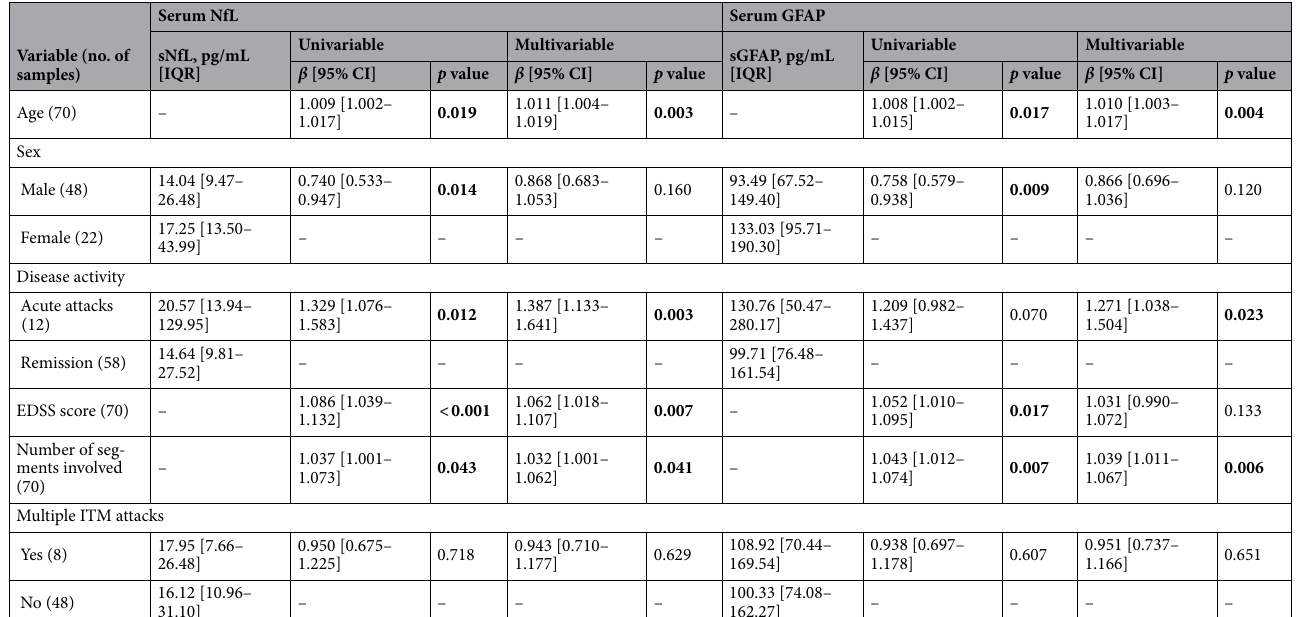
Table 2. Univariable and multivariable models for serum biomarkers in ITM patients. Linear regression models were used to investigate the associations between serum biomarker levels and clinical variables. “Acute attack” stands for a clinical attack within the last two months. Values represent regression coefficient β with 95% CI. β reflects multiplicative effects because the endpoint sNfL and sGFAP were log-transformed. p values with statistical significance ( p < 0.05) are presented in bold. ITM: idiopathic transverse myelitis; sNfL: serum neurofilament; sGFAP: serum glial fibrillary acidic protein; IQR: interquartile range; EDSS: Expanded Disability Status Scale; LETM: longitudinally extended transverse myelitis; CI: confidence interval.